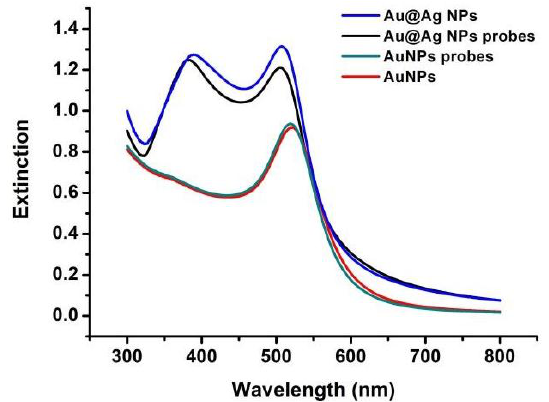
Figure 2. Extinction spectra of Au NPs, AuNPs probes, Au@Ag NPs, and Au@Ag NPs probes.